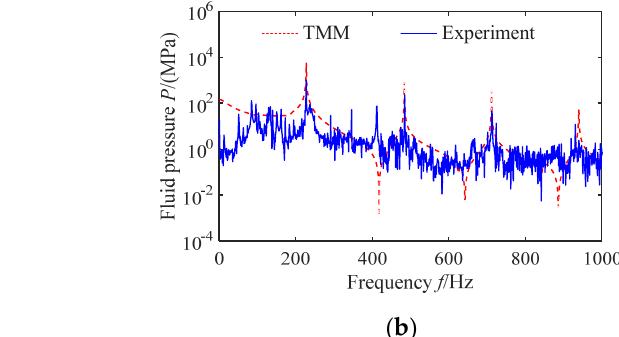
Figure 11. Flow velocity of pipe inlet. ( a ) Cases 1 and 3. ( b ) Cases 2 and 4. Table 7. Natural frequencies of the flow velocity of pipe inlet.